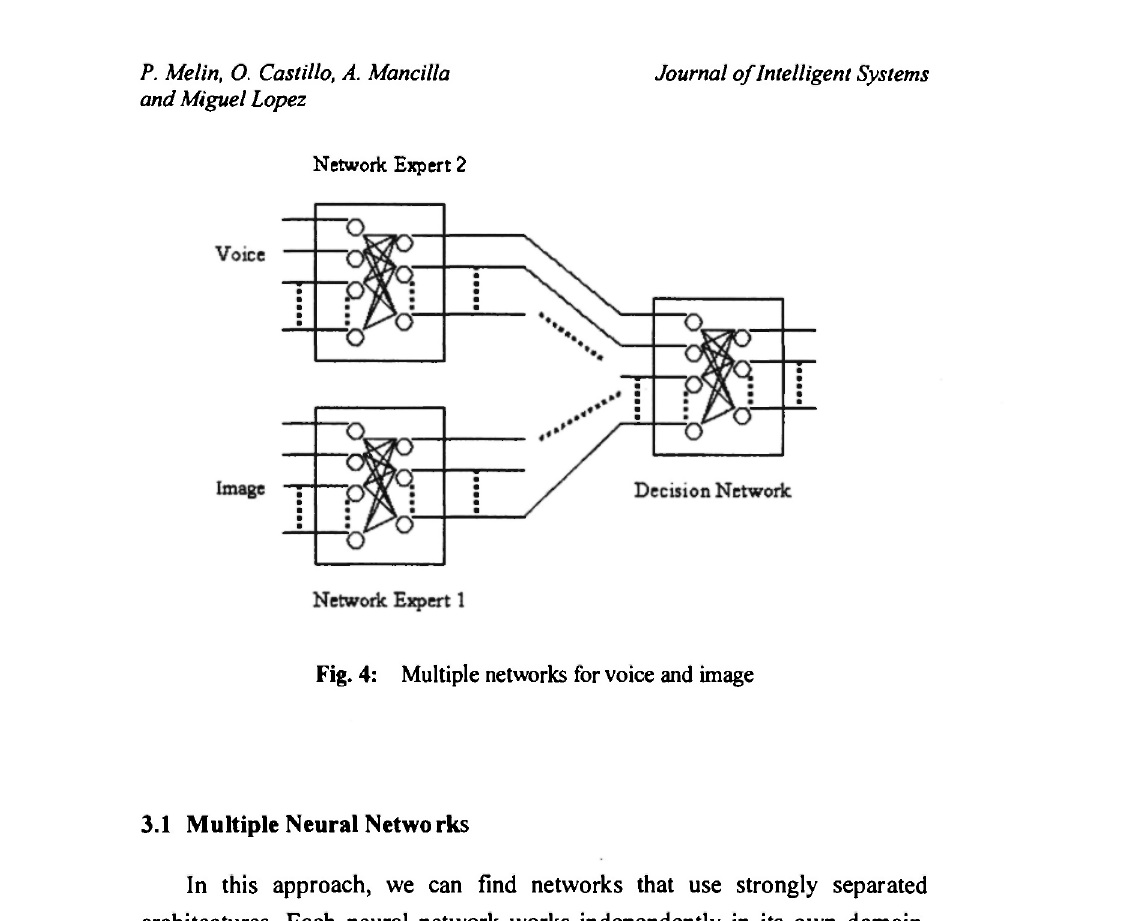
Fig. 4: Multiple networks for voice and